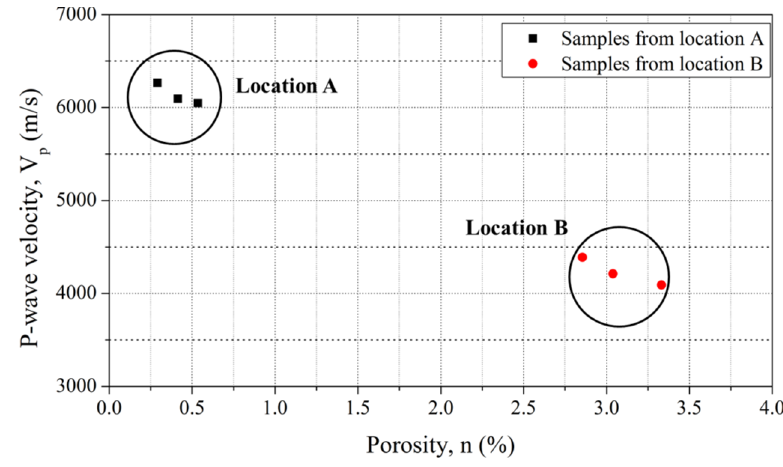
Figure 7. Distribution patterns of samples collected Locations A and B in Ny-Ålesund.